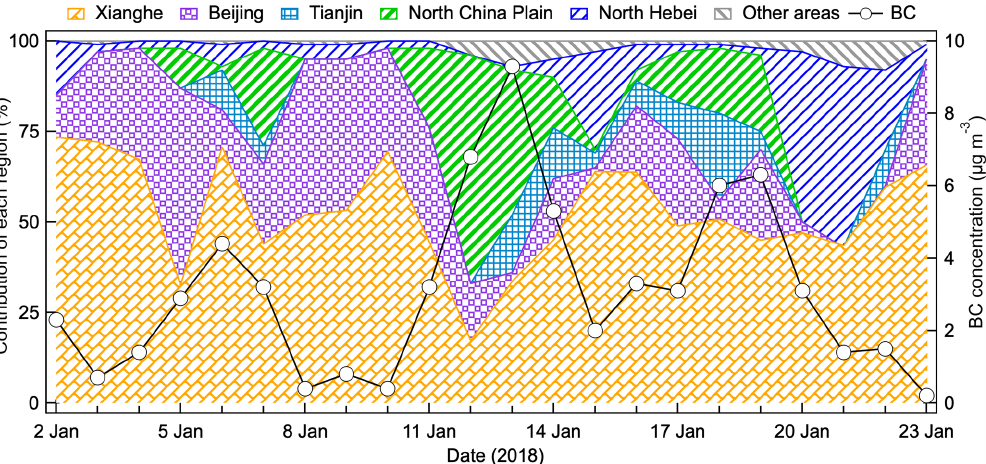
Figure 5. Time series of the mass concentration of black carbon (BC) and the contribution of each source region to the total BC loading from 2 to 23 January,